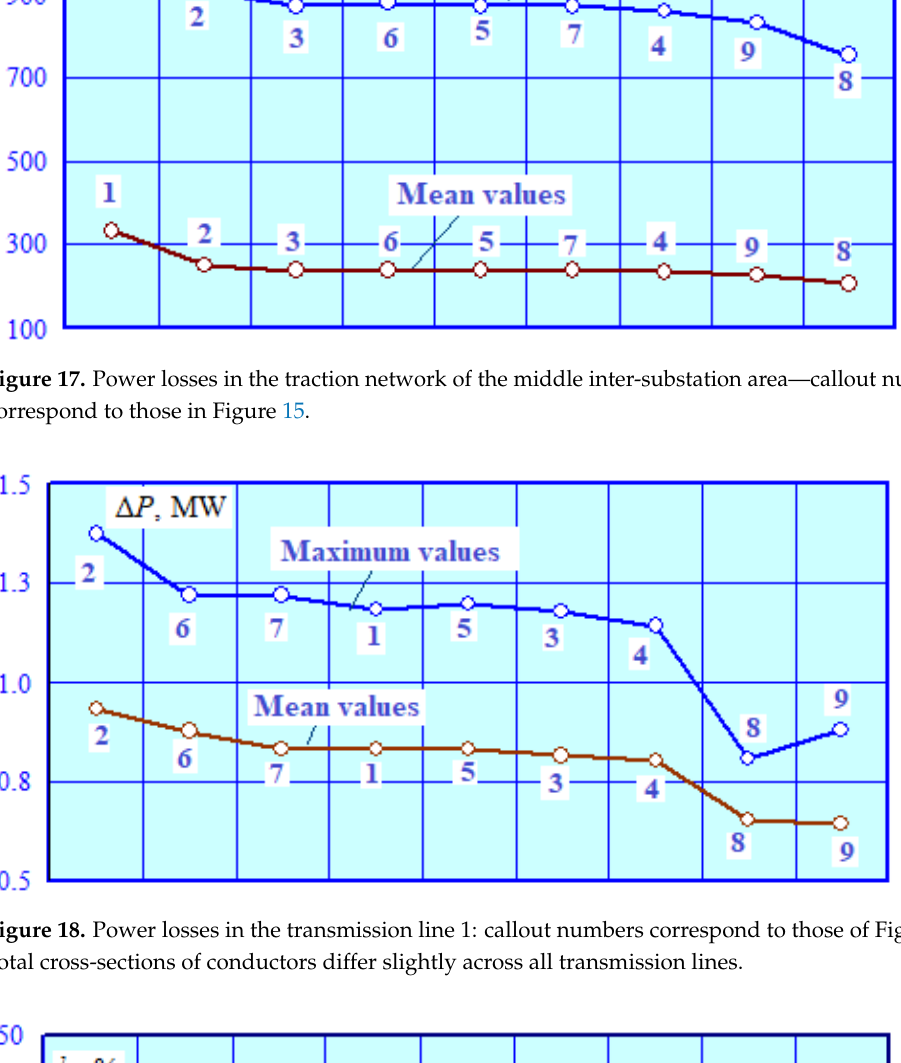
Figure 16. Negative - sequence unbalance ratios at 220 kV buses of TS 4—callout numbers corre- spond to those in Figure 16.